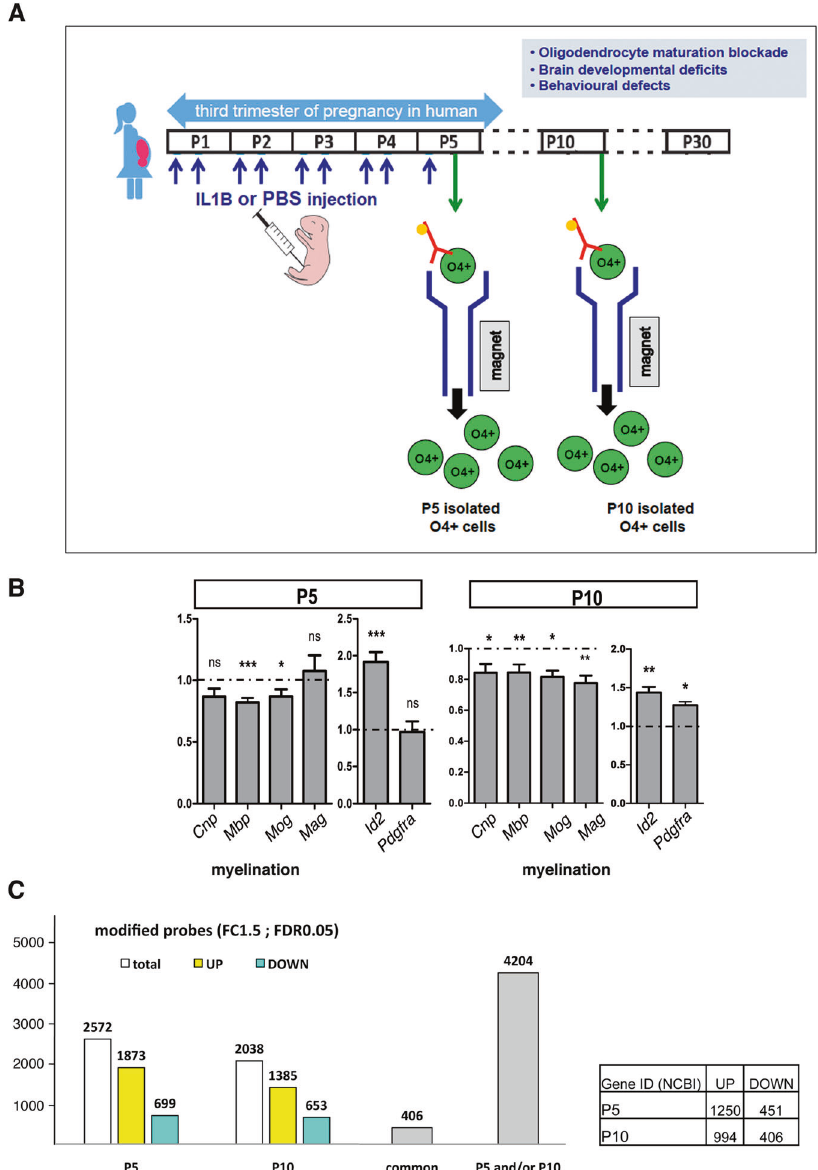
Fig. 1 Experimental strategy and major transcriptomic impact of neuroin fl ammation on the immune/in fl ammatory pathway in O4 + cells. A We used a mouse model of encephalopathy of prematurity that we previously validated and in which we mimic the systemic and neuroin fl ammatory insults as undergone by human infants from approximately (23 – 32)-week gestational age equivalent. Neuroin fl ammation is induced via i.p. IL1B from postnatal days 1 – 5, and this leads to OPC maturation blockade, defective myelination, and behavioral anomalies as seen clinically [8]. O4 + cell populations (green circles) were respectively isolated from P5 and P10 pup cortices by MACS (see “ Materials and methods ” ). B Quality-control validation of OPC maturation arrest in the model of perinatal neuroin fl ammation. RT-qPCR analysis of the expression of myelination and progenitor markers in O4 + cells showing that neuroin fl ammation, induced by IL1B peritoneal injections in pups, results in defects in the myelination gene expression program and inappropriate elevation of progenitor markers at P5 and P10. Myelin markers: Mbp , Myelin binding protein; Mog , Myelin oligodendrocyte glycoprotein; Mag Myelin-associated glycoprotein. Plp1 proteolipid protein 1, a transmembrane, predominant component of myelin; Cnp , 2 ′ ,3 ′ -Cyclic Nucleotide 3 ′ Phosphodiesterase, abundant protein in myelin in the central nervous system. Progenitor (OPC) markers: Id2 , Inhibitor of differentiation 2; Pdgfra , Platelet Derived Growth Factor Receptor Alpha. Number of independent experiments at P5: n = 7 for Cnp , Mag , and Pdgfra ; and n = 15 for Mbp , Mog , and Id2 ; at P10: n = 14 for Mag and Mog ; and n = 19 for Cnp , Pdgfra ; and Mbp , and Id2 . ns not statistically signi fi cant; * p < 0.05; *** p < 0.001. C (Left) Graphical representation of the total number of probes dysregulated upon neuroin fl ammation induced by IL1B injections in O4 + cells at P5 and P10 (white; 2572 probes at P5 and 2038 probes at P10) including upregulated (yellow; 1873 probes at P5 and 1385 probes at P10) and downregulated (blue; 699 probes at P5 and 653 probes at P10) probes; gray bars: number of probes dysregulated at P5 and P10 (common), and dysregulated at least at one stage (P5 and/or P10). (Right) Number of upregulated (UP) and downregulated genes (DOWN), at P5 or P10. mRNAs in naïve pups, compared to PBS-treated ones (Fig. 2D). This would be responsible for induced expression of cytokine and shows that PBS intraperitoneal injections are not responsible per se chemokine genes, we compared MACS-isolated O4 + cells from for the constitutive cytokine and chemokine mRNA levels naïve (non-injected) and PBS-injected pups at P5, in RT-qPCR physiologically observed at P5. experiments. We observed similar levels of cytokine and chemokine Cell Death and Disease (2022)